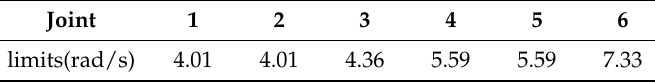
Table 2. The joint velocity limits of the Efort